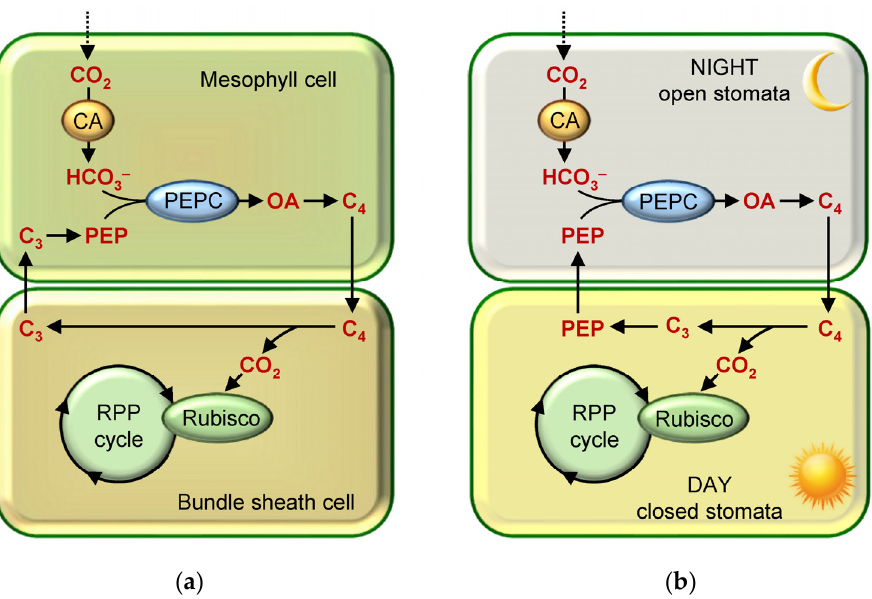
Figure 1. Schematic representation of dark phase photosynthesis reactions in ( a ) C 4 plant cells; ( b ) CAM plants. Abbreviations: C 3 /C 4 —C 3 /C 4 -dicarboxylic acids; OA—oxaloacetate; PEP—phosphoenolpyruvate; PEPC—phosphoenolpyruvate carboxylase.